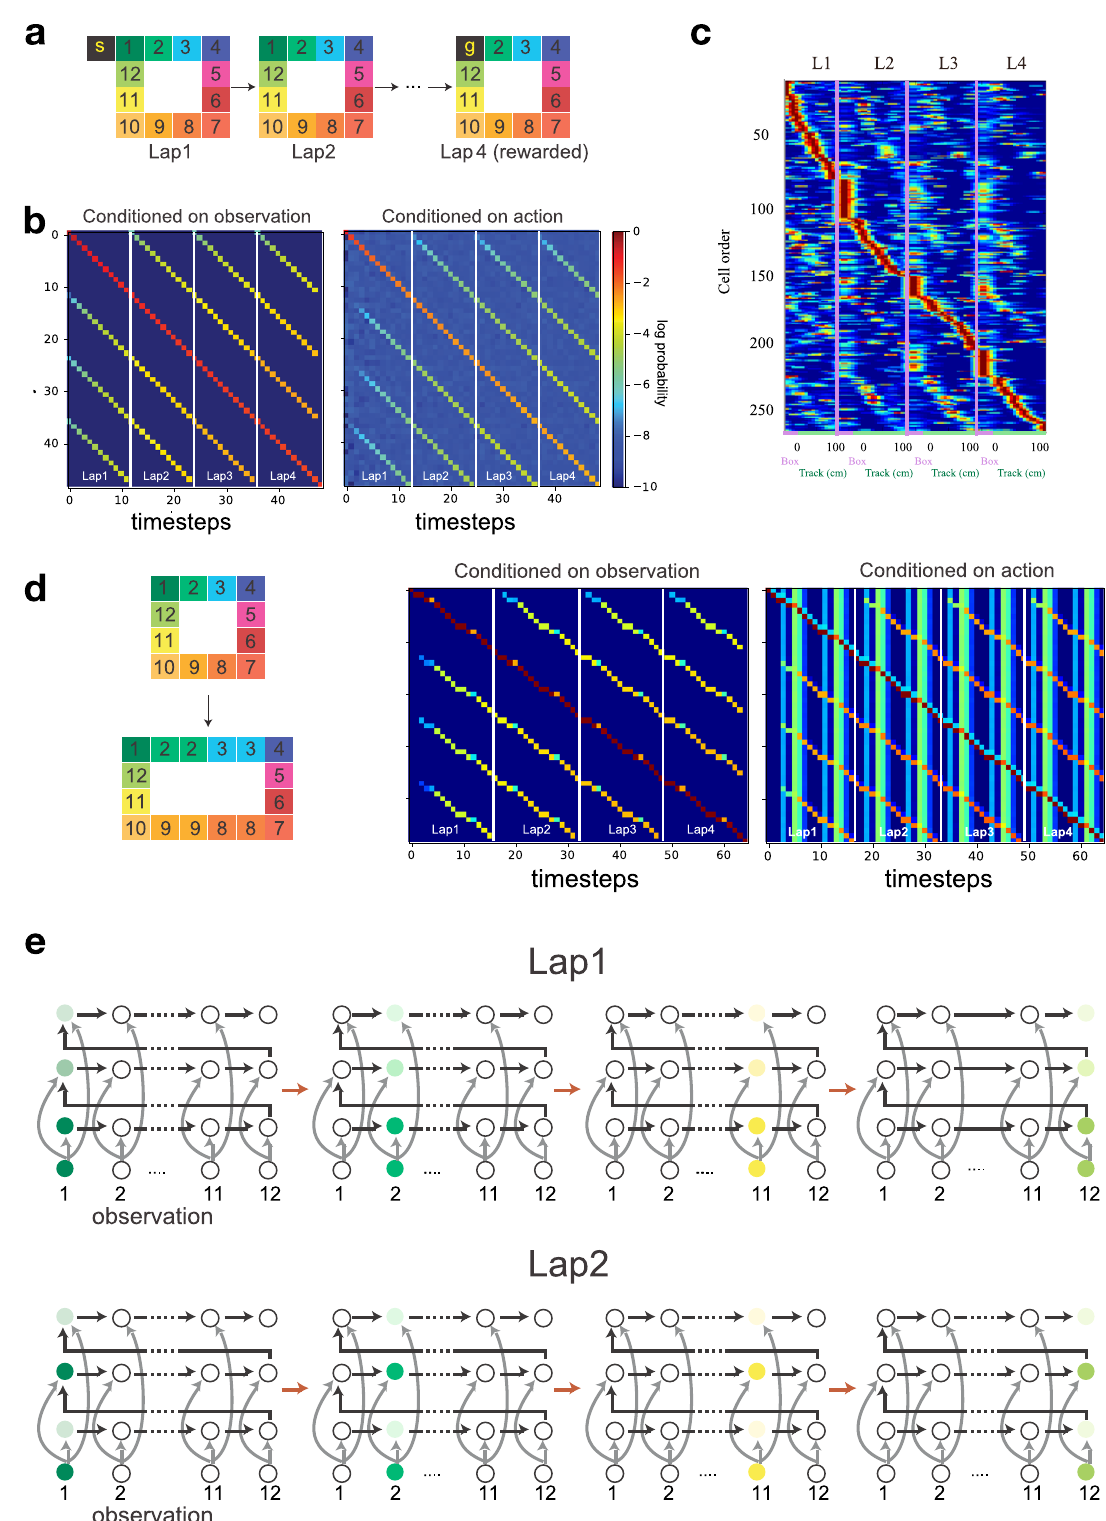
response, despite the ambiguous instantaneous observations.